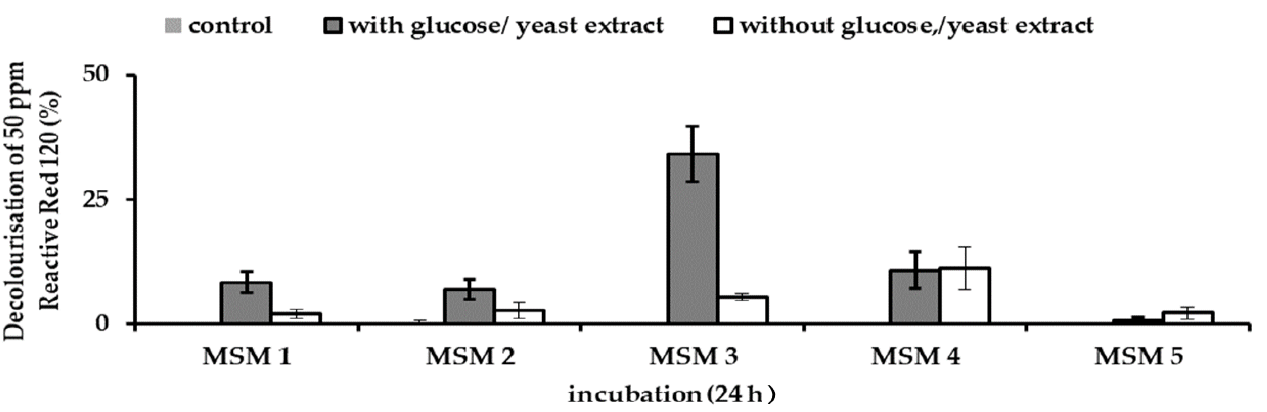
Figure 7. Effect of glucose and yeast extract in the media composition on the decolourisation of 50 ppm Reactive Red 120 by consortium JR3 at 24 h. Data represent mean ± SD, n = 3.